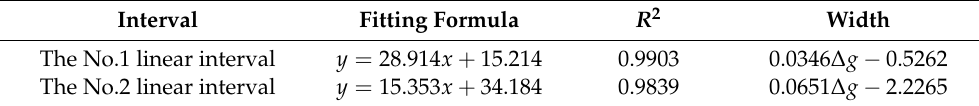
Table 3. The functional relationship between the crack width and the gray difference.